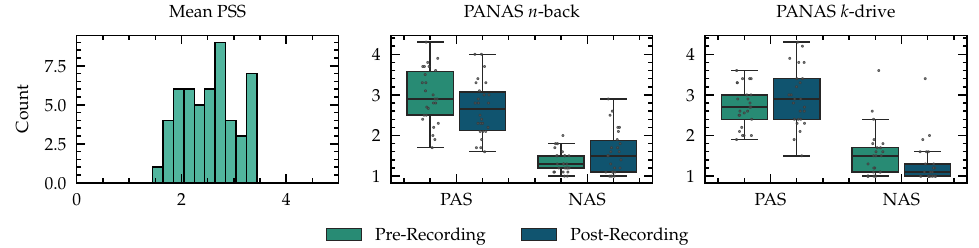
Figure A3. Results of PSS and PANAS questionnaires. The first column shows the distribution of mean values of Perceived Stress Scale (PSS) answered during the questionnaire phase, indicating the long-term stress values of the study population. The second ( n -back) and third ( k -drive) columns present the mean PANAS rating for positive affection sub-schedule (PAS) and negative affection sub-schedule (NAS) before and after the